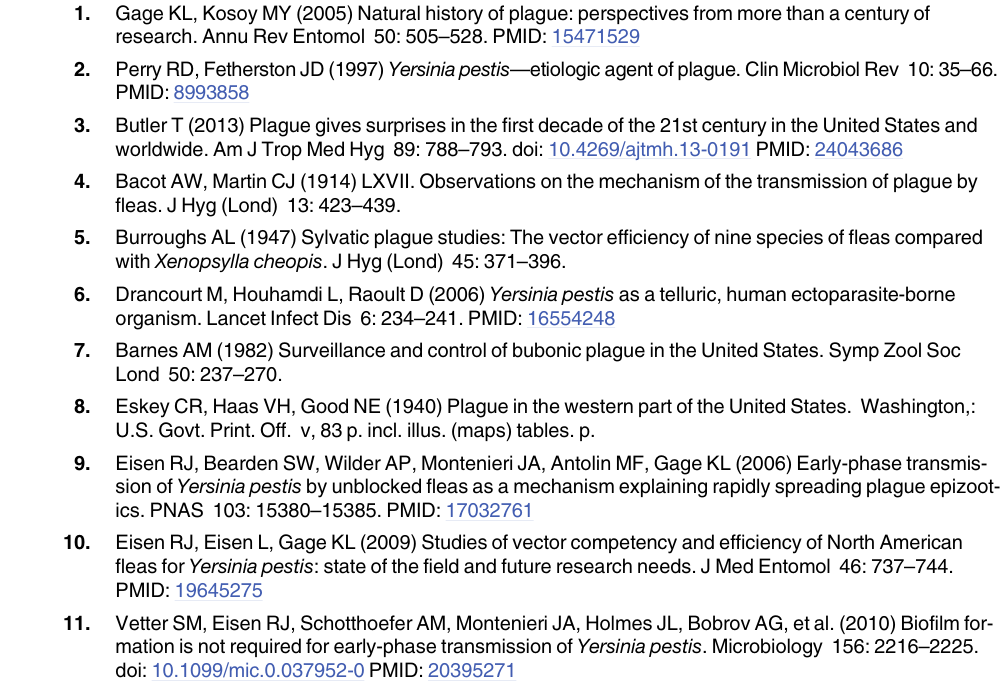
S6 Fig. Hydrogen peroxide sensitivity of Y . pestis mutants. Y . pestis cultures were mixed with hydrogen peroxide to give a final concentration of 10 7 CFU/mL in 2.5 mM H utes of incubation at 26°C, bacteria were diluted into HIB to quench the reaction and then enu- merated by plating on HIA. Reactions were performed in triplicate and means with standard error are shown. ANOVA with Dunnett post-test was done to compare all strains to the KIM6- + control. (cid:3) P <